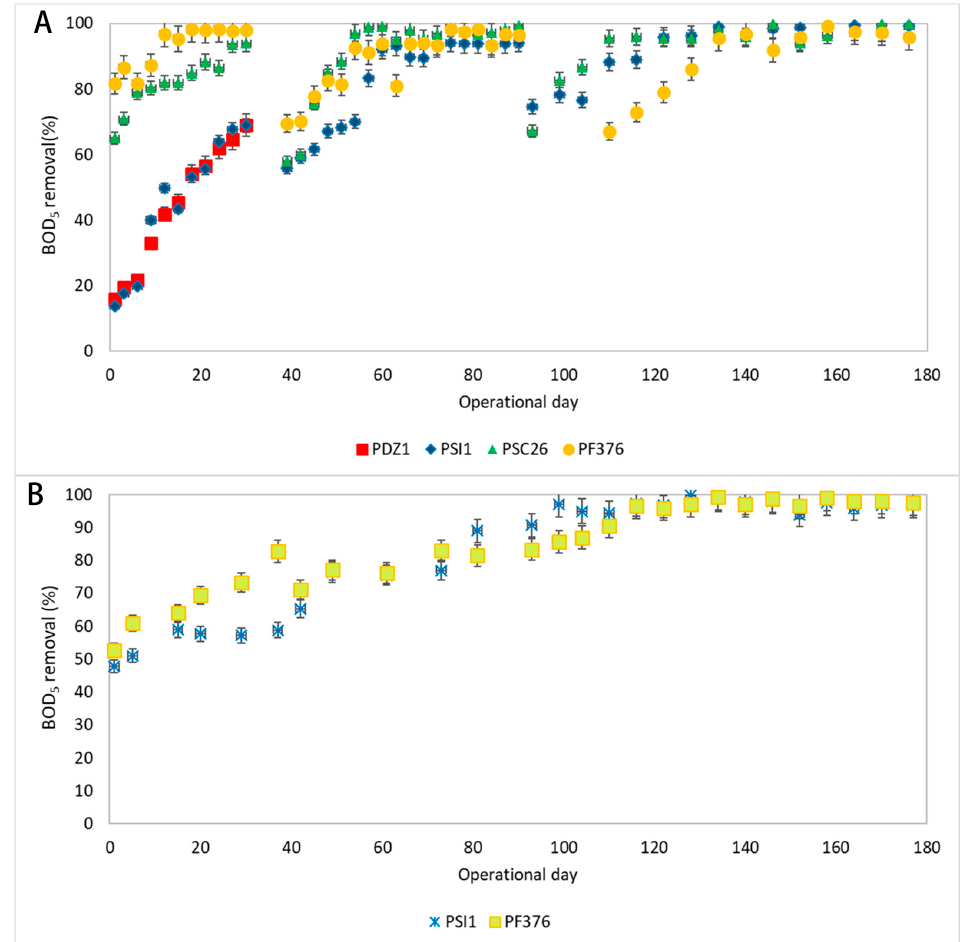
Figure 6. BOD 5 removal by granular biomass for Pseudomonas fluorescens PSC26 (PSC26), Pseudomonas fluorescens 376 (PF376), Pseudomonas stutzeri I1 (PSI1), and Pseudomonas denitrificans Z1 (PDZ1) fed with sodium acetate ( A ) and methanol ( B ).